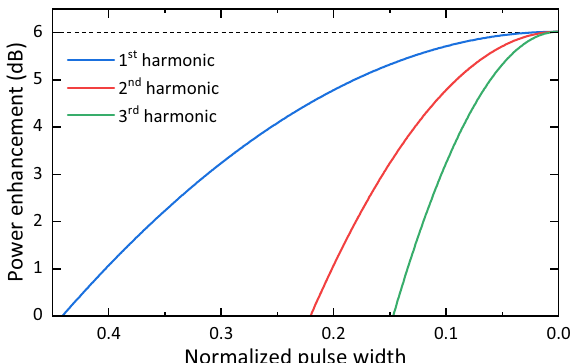
Figure 8. Power gain achieved with a pulsed Gaussian source at different harmonics versus normalized pulse width.